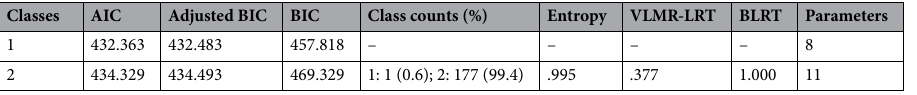
Table 4 represents the model fit statistics for all GMM models concerning depression and anxiety (i.e., from one to four latent classes). For the GMM models with more than three classes, the variance of the slope was fixed at zero because of the negative definite in the covariance matrices. The BLRT and VLMR-LRT were significant for the three-class model, and the BIC- value was the lowest, indicating that the three-class model fitted the data better than the two-class solution. The three-class model included a small subgroup containing five participants, that is, 3% of the sample. Although